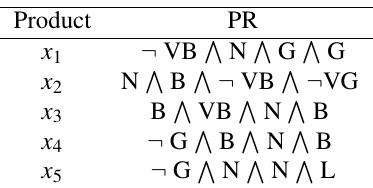
Table 3. Reputation of Product x i to X